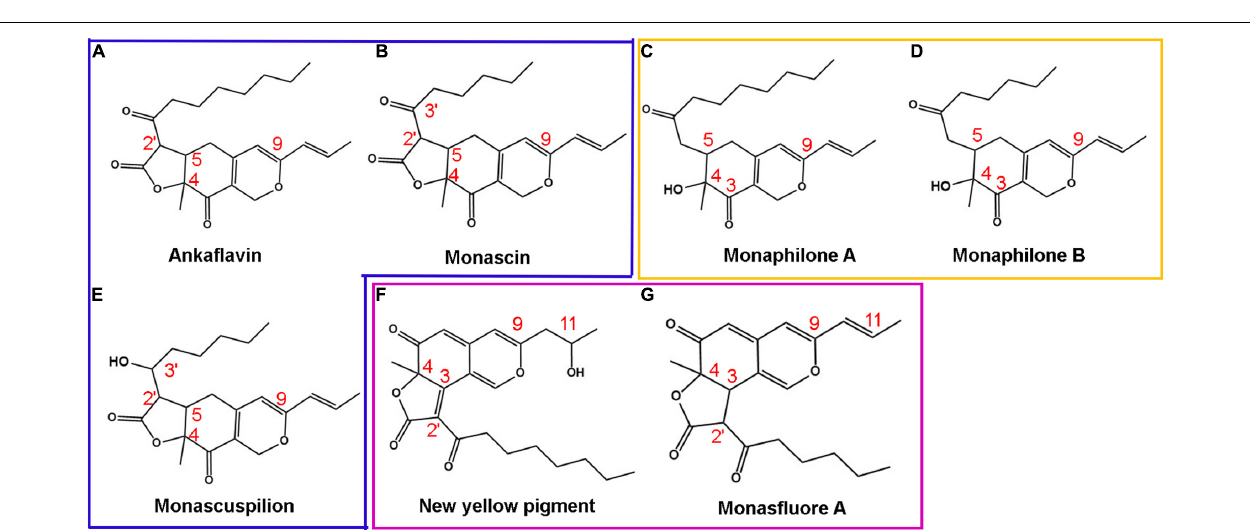
Frontiers in Microbiology |